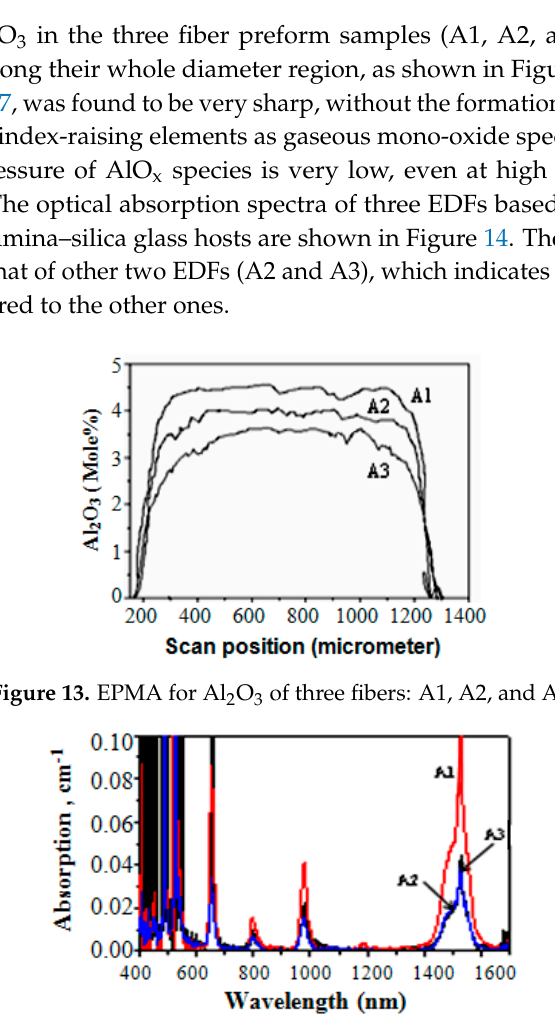
Figure 14. Absorption curves of three EDFs: A1, A2, and A3.